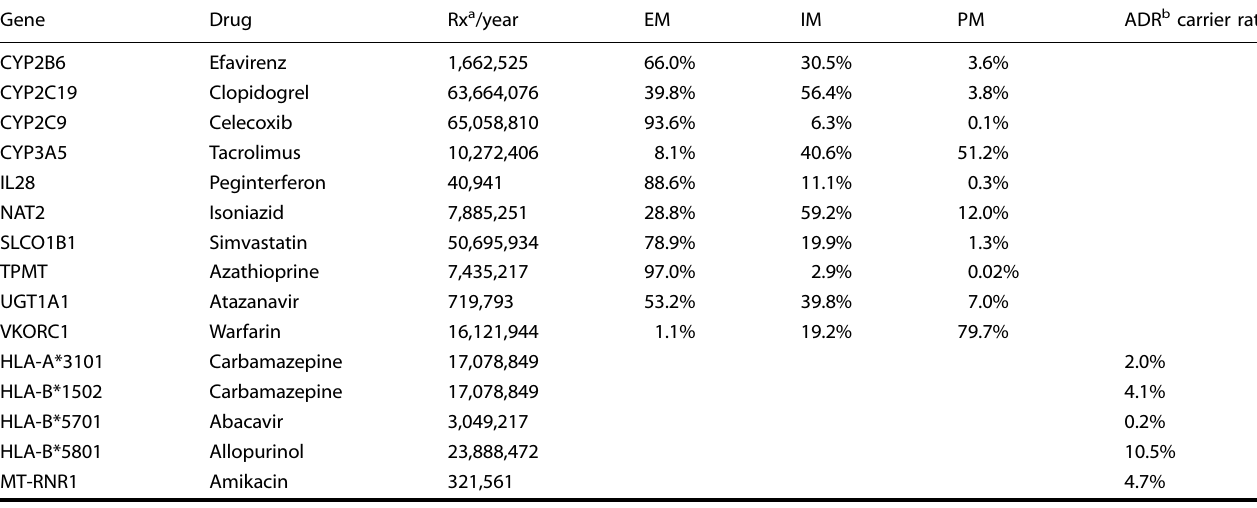
Table 5. Frequency distribution of pharmacogenetic phenotypes predicted by genotypes of TWB